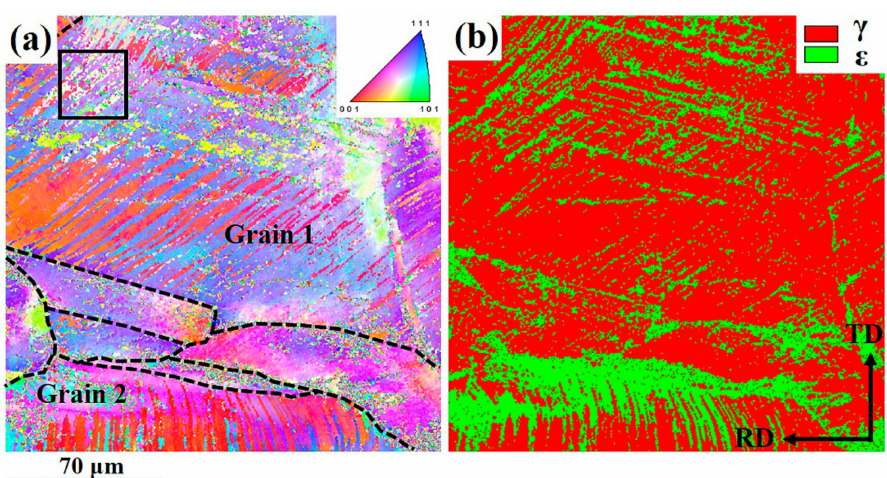
Figure 7. Microstructure of tensile deformed specimen with warm rolling reduction of 35%: ( a ) The RD orientation maps, ( b ) phase map.